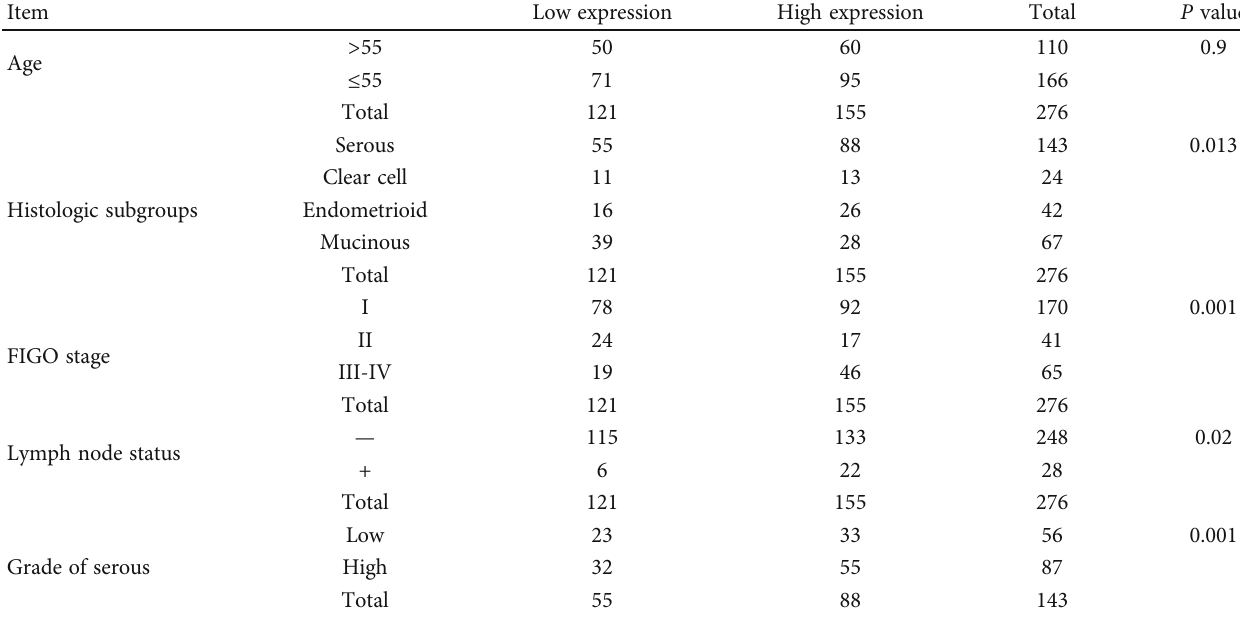
Table 1: Correlation of WTAP expression with patient ’ s clinical and pathological characteristics.